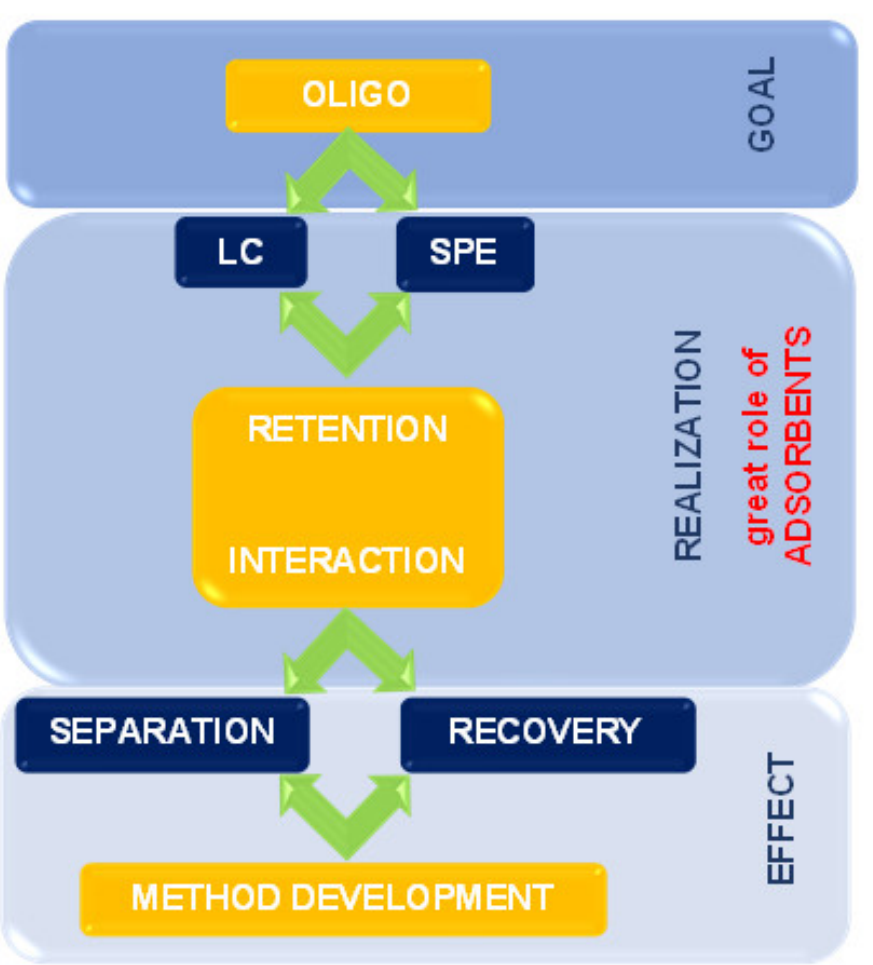
Figure 2. The scheme indicates the place and role of solid materials used in ASO analysis.